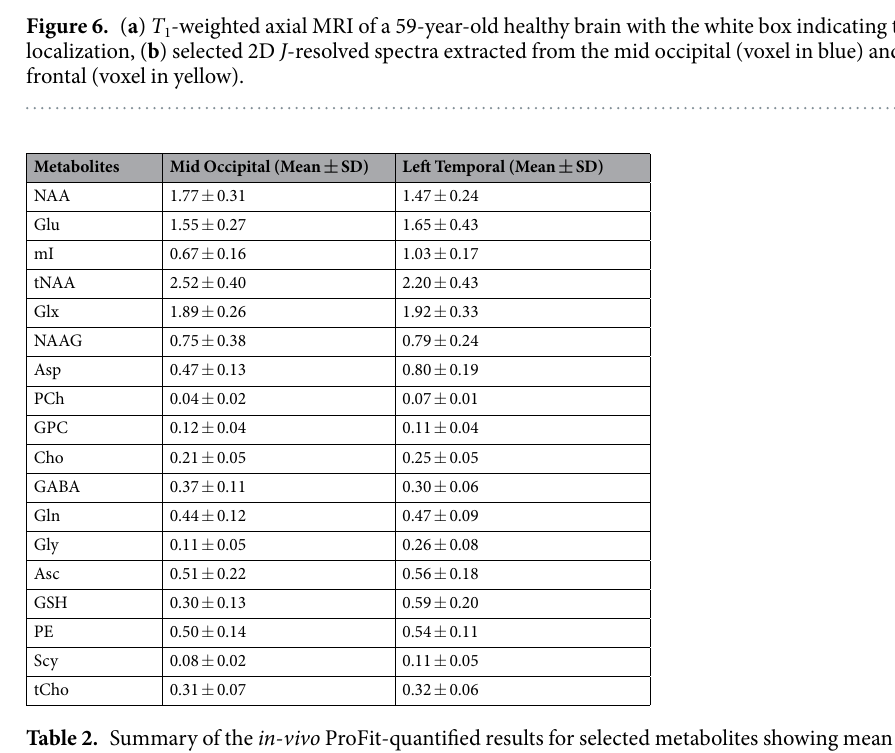
Table 2. Summary of the in - vivo ProFit-quantified results for selected metabolites showing mean metabolite ratios ( ± SD) with respect to Cr in the mid occipital (voxel in blue in Fig. 6(a)) and left temporal lobe (voxel in red in Fig. 6(a)) of 10 healthy